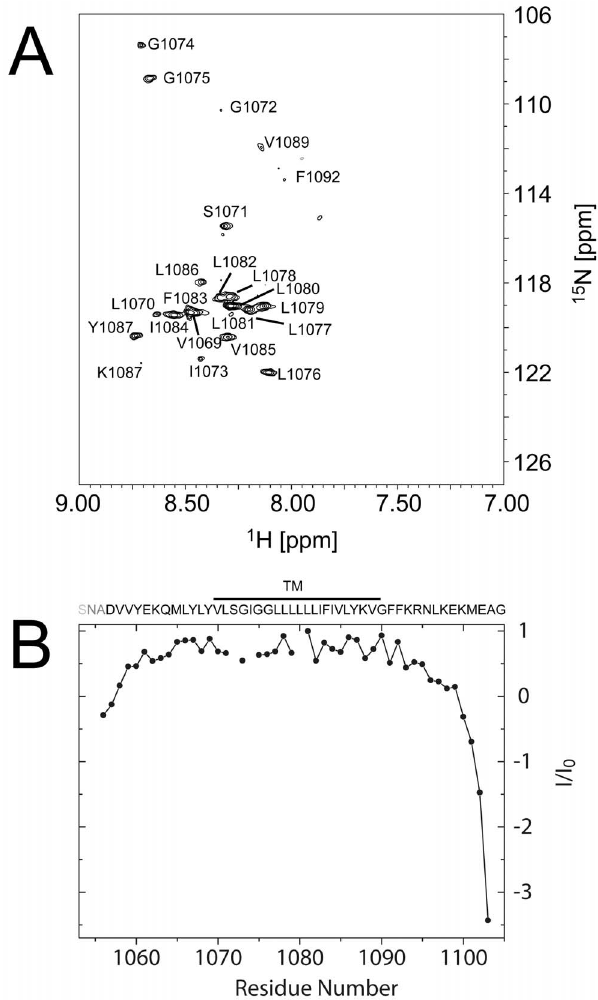
Figure 3. Integrin a L TM H N -H 2 O chemical exchange and backbone dynamics. (A) [ 1 H- 15 N]-TROSY-HSQC spectra in 99% D 2 O. The cross peaks are labeled by one-letter code and the residue number; (B) [ 1 H, 15 N] steady-state heteronuclear NOE experiment. The three extra N-terminal residues, SNA, are grayed out. The residues protected from H/D exchange are indicated by a line, and labeled as TM.